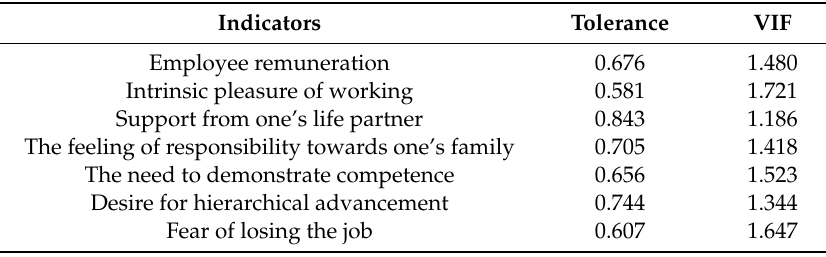
Table 6. Multicollinearity test (VIF)